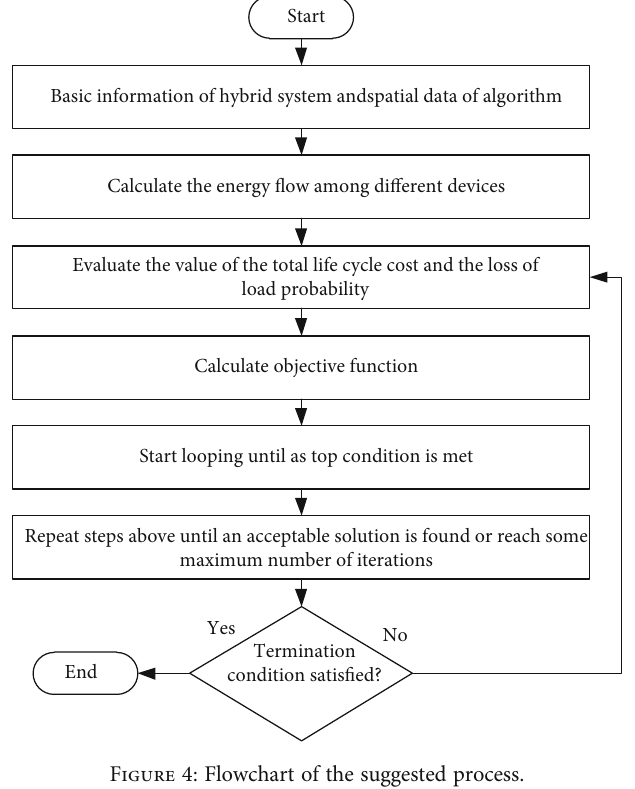
Figure 4: Flowchart of the suggested